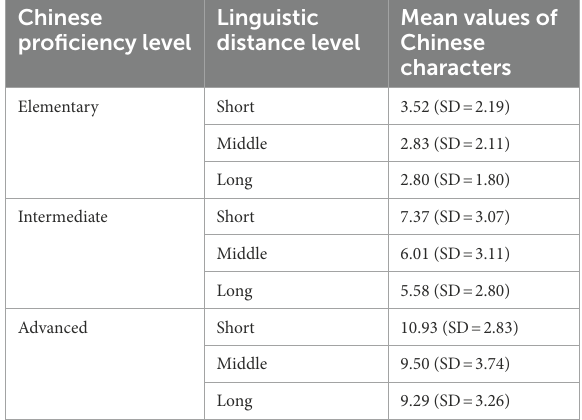
TABLE 2 Chinese character test score descriptive